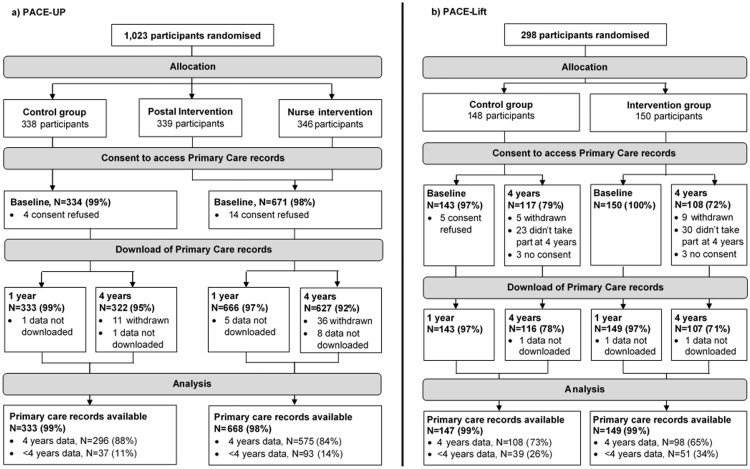
(a) PACE-UP and (b) PACE-Lift CONSORT diagrams for primary care records analyses.Complete data for 4 years were only available on those participants who were registered at the same primary care practice at baseline and 4 years. 7 deaths in PACE-UP participants (2 Control. 5 Intervention) and 4 deaths in PACE-Lift participants (2 Control. 2 Intervention) were recorded on registered patients. Data for those participants who moved away or had died before 4 years are censored when they left the practice or at their date of death.